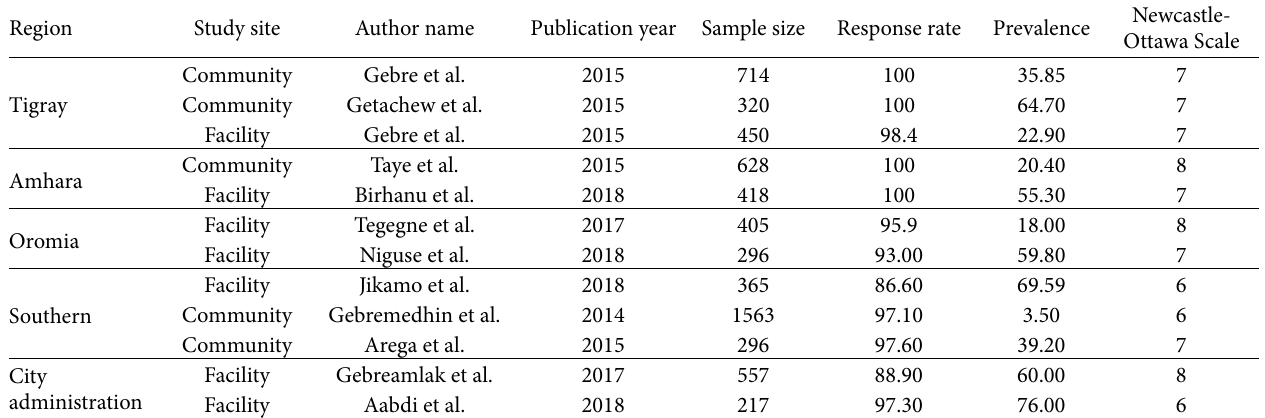
Table 1: Descriptive summary of 12 studies included in the meta-analysis of prevalence compliance to iron-folic acid supplementation in Ethiopia,